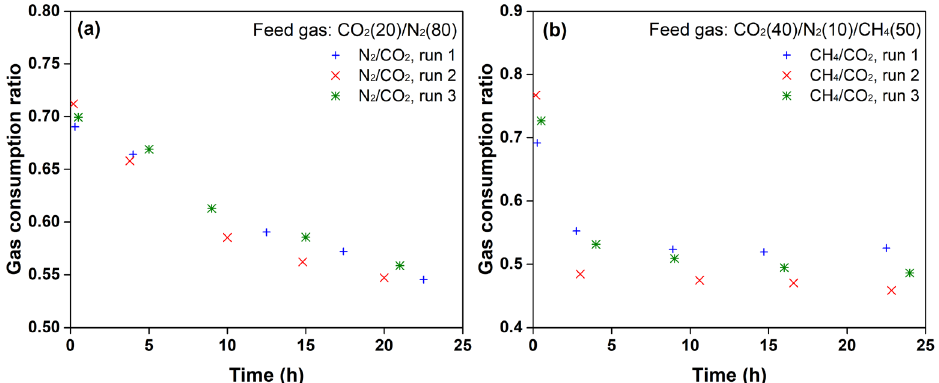
Figure 7. The gas consumption ratio of N 2 to CO 2 and CH 4 to CO 2 in the hydrate formation from flue gas and biogas,